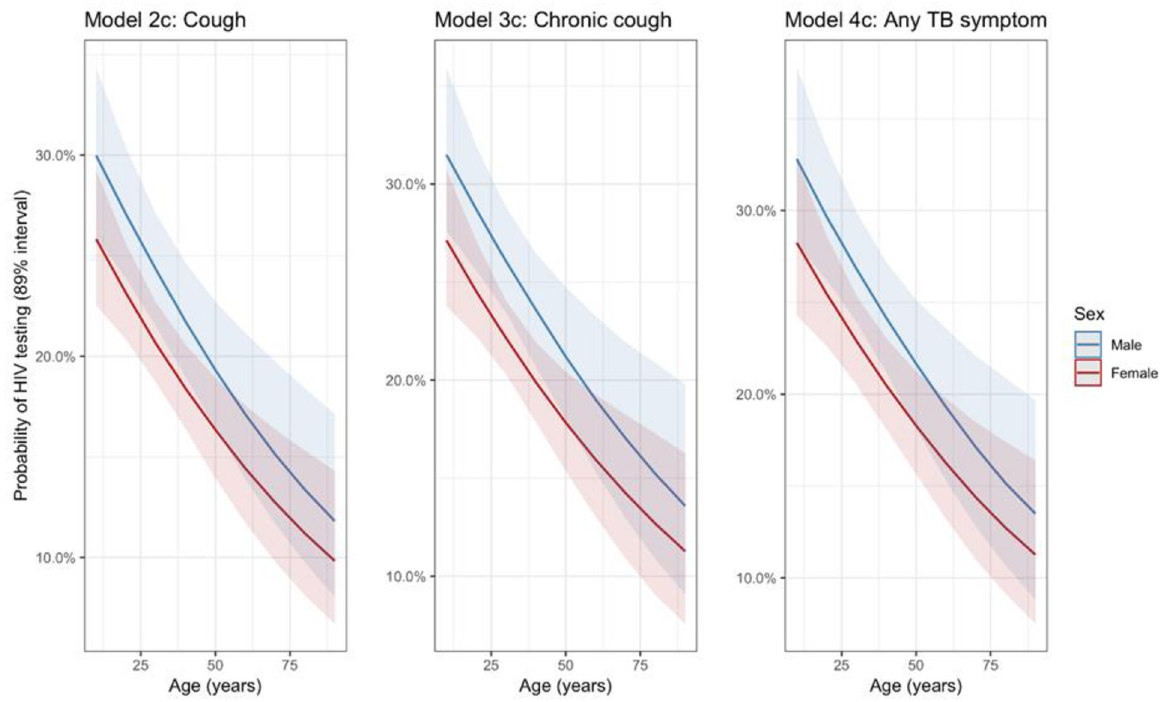
Fig 3. Predicted probability of HIV testing by age and sex. Predicted probabilities are estimated from multivariable Bayesian regression models, adjusted for no history of previous TB and not having tested previously for HIV.